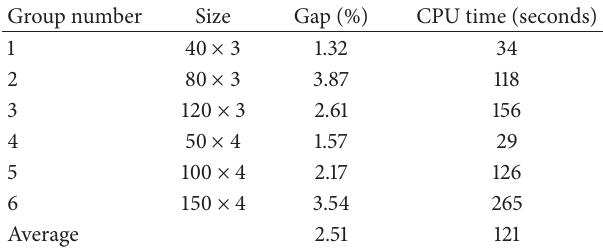
Table 4: Theaverage experiment resultsforthegenerated 6problem sizes.